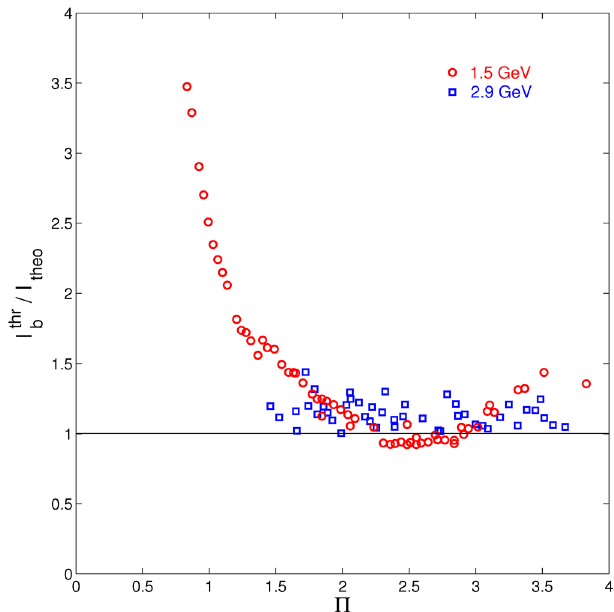
FIG. 9. Ratio of the experimental to theoretical threshold currents at 2.9 and 1.5 GeV plotted against the shielding parameter Π from the theory of Bane et al. [9]. The rapid rise below Π ≈ 1 . 5 indicates a breakdown of the linear relation- ship Eq. (11).